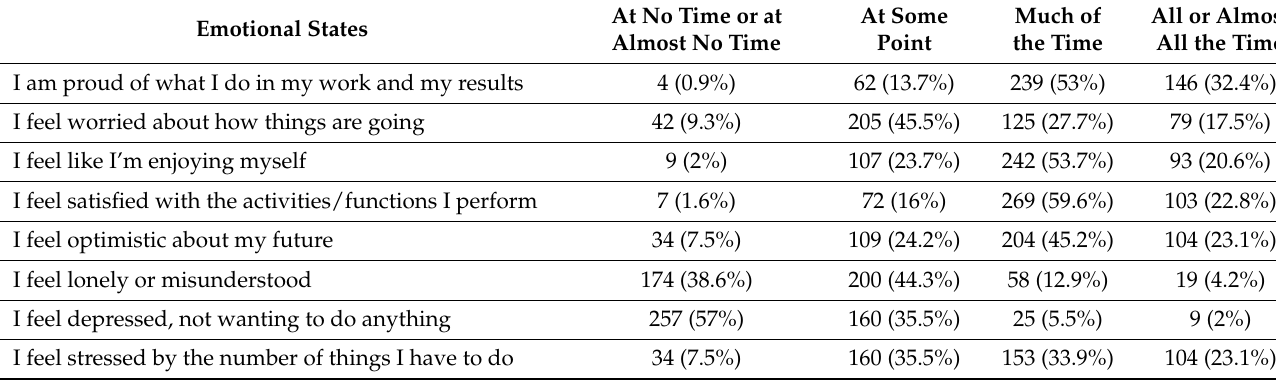
Table 2. Frequencies and percentages distribution in SEWBI.